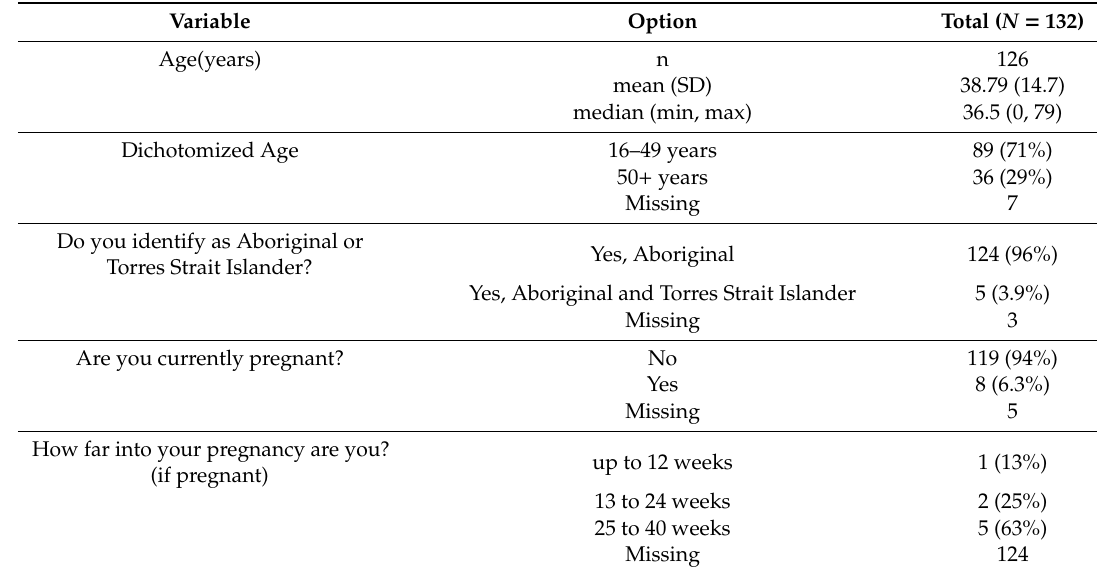
Table 1. Demographic Characteristics of